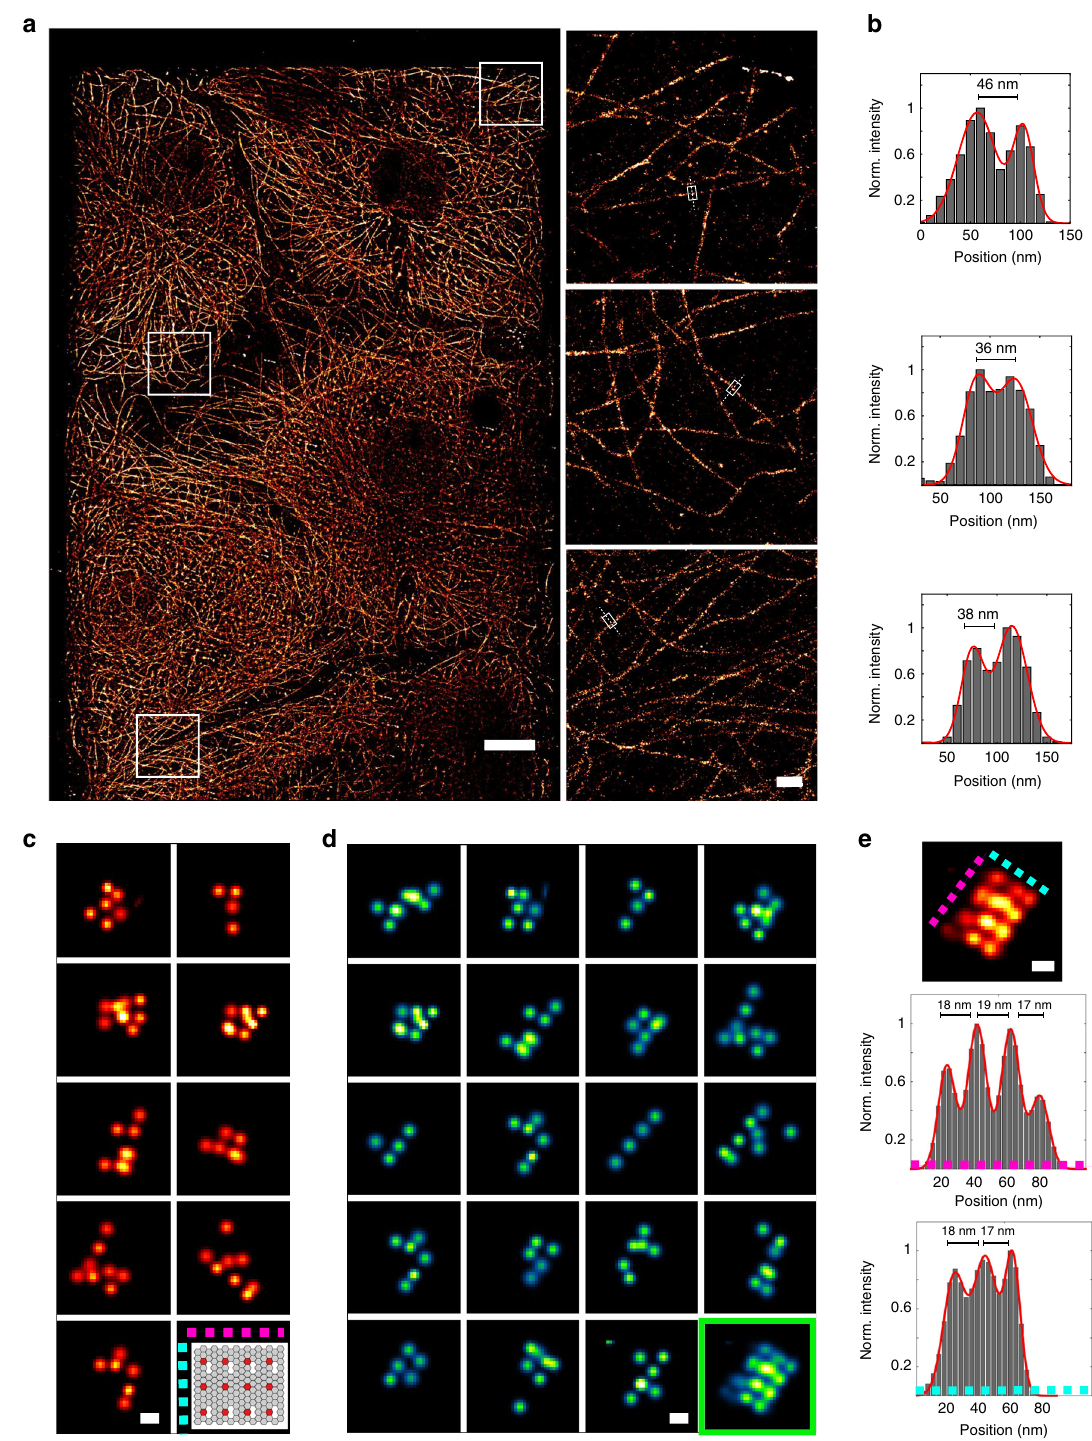
Fig. 3 Demonstration of waveguide-PAINT. a Single FOV DNA-PAINT reconstruction of COS-7 cells cultured on a waveguide, labeled with antibodies against α -tubulin and imaged using a 500 pM concentration of imager strand (I1-655, Ultivue Duplex Kit) (left panel). Magni fi ed views of the boxed regions (left panel, from top to bottom) show microtubules well-resolved across the FOV ( a right panel). b Intensity pro fi les across individual microtubules (as de fi ned in a right panel) reveal two peaks that can be described by the sum of two Gaussian functions ( b red line). c Magni fi ed regions from a single FOV of DNA-PAINT reconstructions of a 20-nm-grid DNA origami imaged with Cy5-conjugated imager strands (500 pM). d Aligning single DNA origamis to create an average (green box) reveals the 4 × 3 grid arrangement as well as the respective grid spacing. e Intensity pro fi les along colored axes in d indicated in top averaged image. Scale bars: 10 µ m ( a ), 0.5 µ m ( a right panel) and 20 nm ( c and d